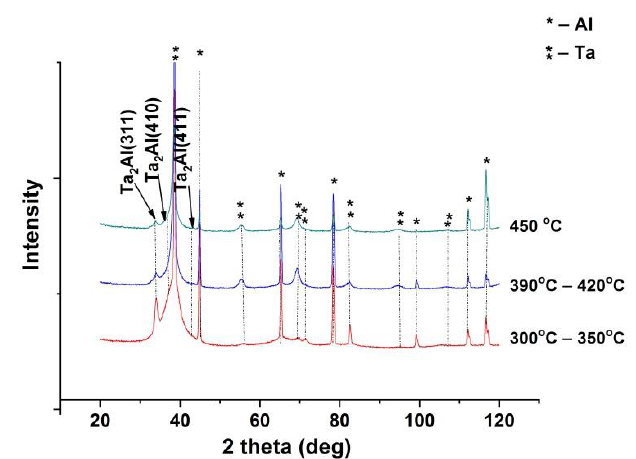
Figure 6. X-ray diffraction (XRD) patterns of a Ta coating on a gradient aluminum substrate. Condensation temperature: 300–350 °С (red), 390–420 °С (blue), and approximately 450 °С (green).